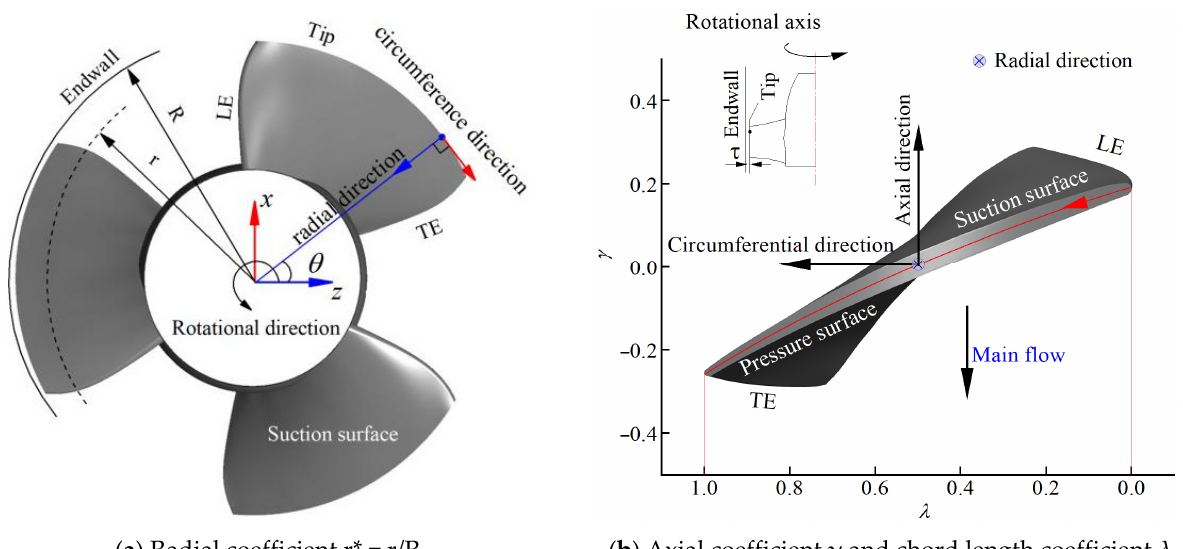
Figure 2. Geometric definition of the impeller.